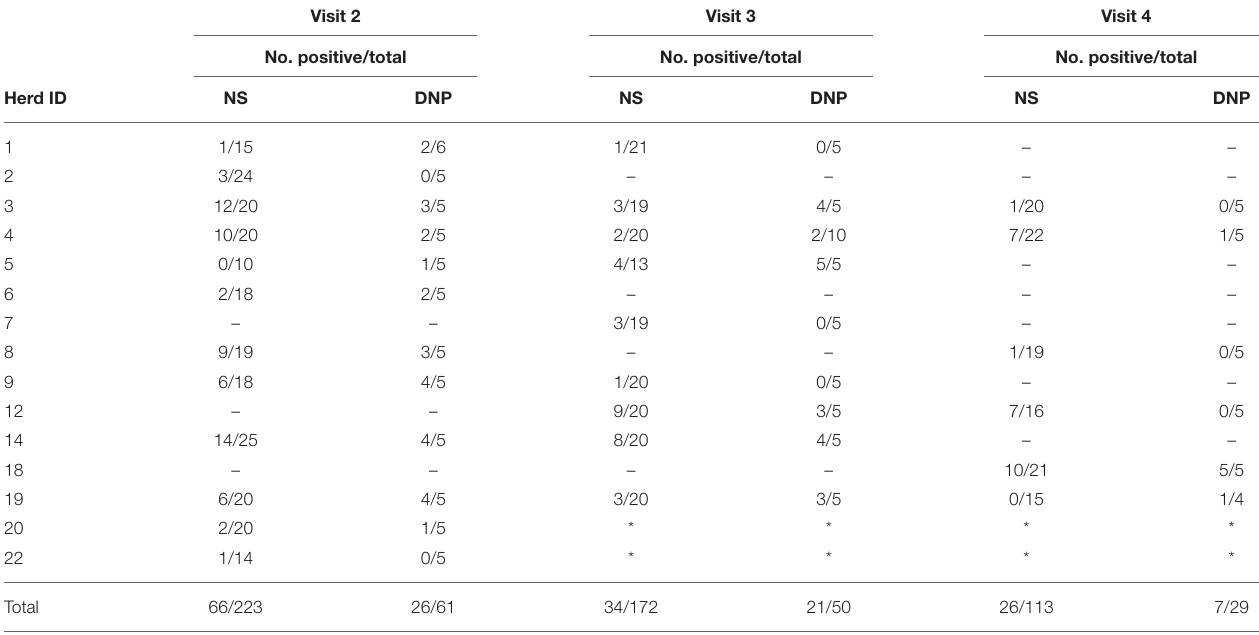
TABLE 5 | M. bovis in nasal (NS) and deep nasopharyngeal (DNP) swabs during visits 2–4 to farms with a positive infection status. Visit